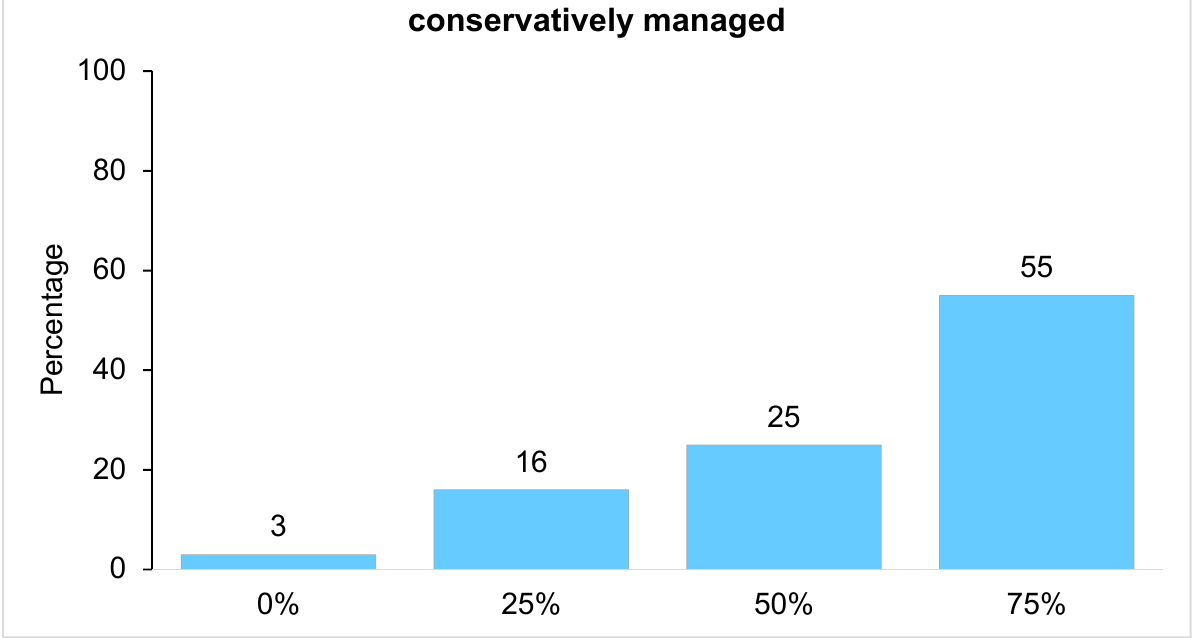
Figure 1. Respondents’ indication of the first-choice P2Y 12 inhibitor in all acute coronary syndrome clinical settings. ( A ): Indication of the first-choice P2Y 12 inhibitor in ST-segment elevation myocardial infarction (STEMI). ( B ): Indication of the first-choice P2Y 12 inhibitor in non ST-segment elevation myocardial infarction (NSTEMI). ( C ): Indication of ticagrelor percentage of use in NSTEMI conservatively managed.